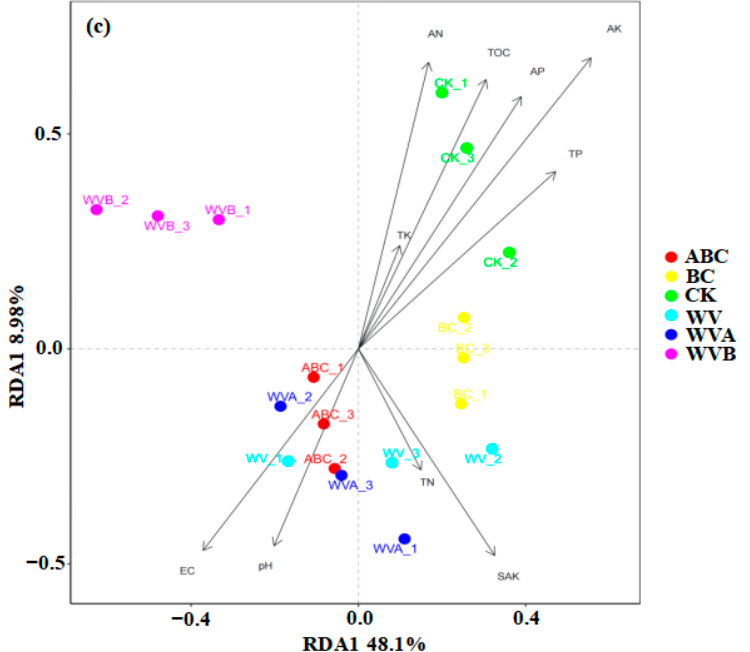
Figure 6. ( a ) The relative abundance of the top 10 bacterial phyla in the coastal saline–alkali soil, the heat map of the top 35 bacterial at the family level. ( b ) The color intensity of the scale demonstrates the relative abundance of each genus. ( c ) Redundancy analysis (RDA) between microbial family relative abundance and soil properties in different treatments.